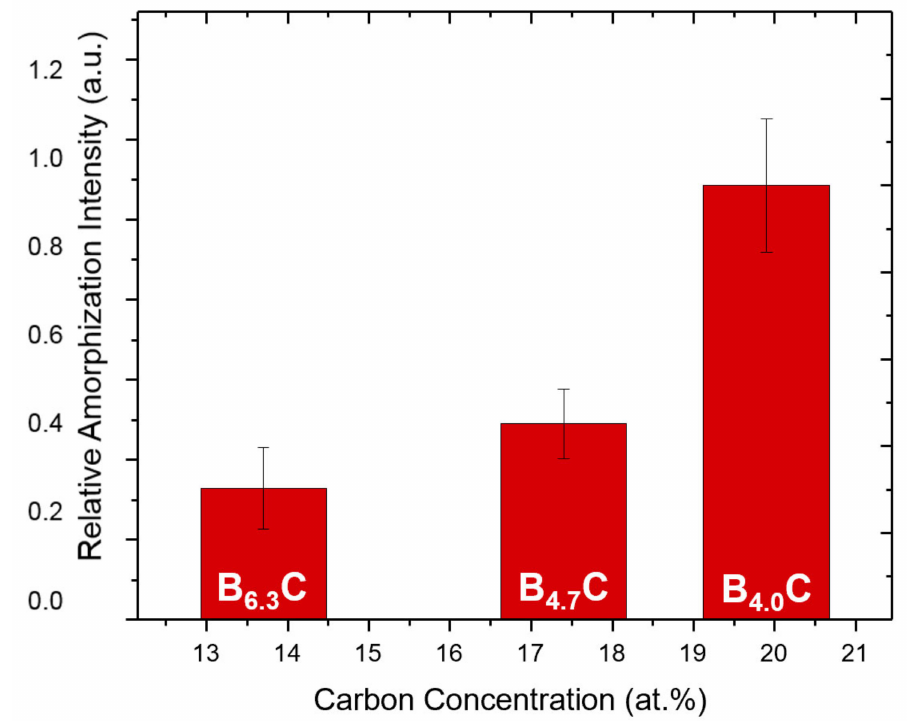
Figure 4. Graphic results of amorphization intensity mitigation for boron-rich boron